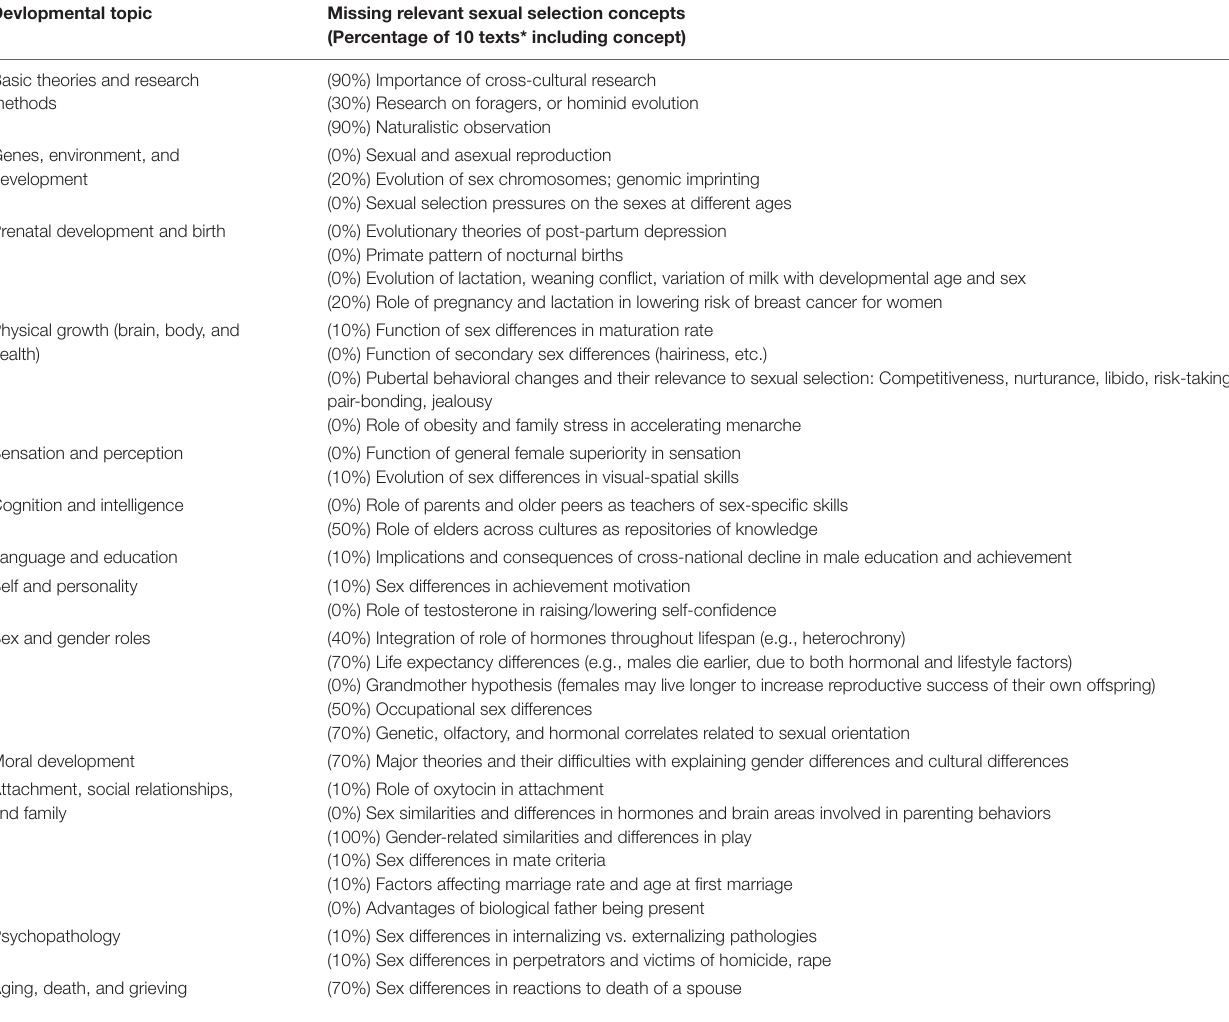
TABLE 1 | Topics for sexual selection usually missing from mainstream texts on developmental psychology. Devlopmental